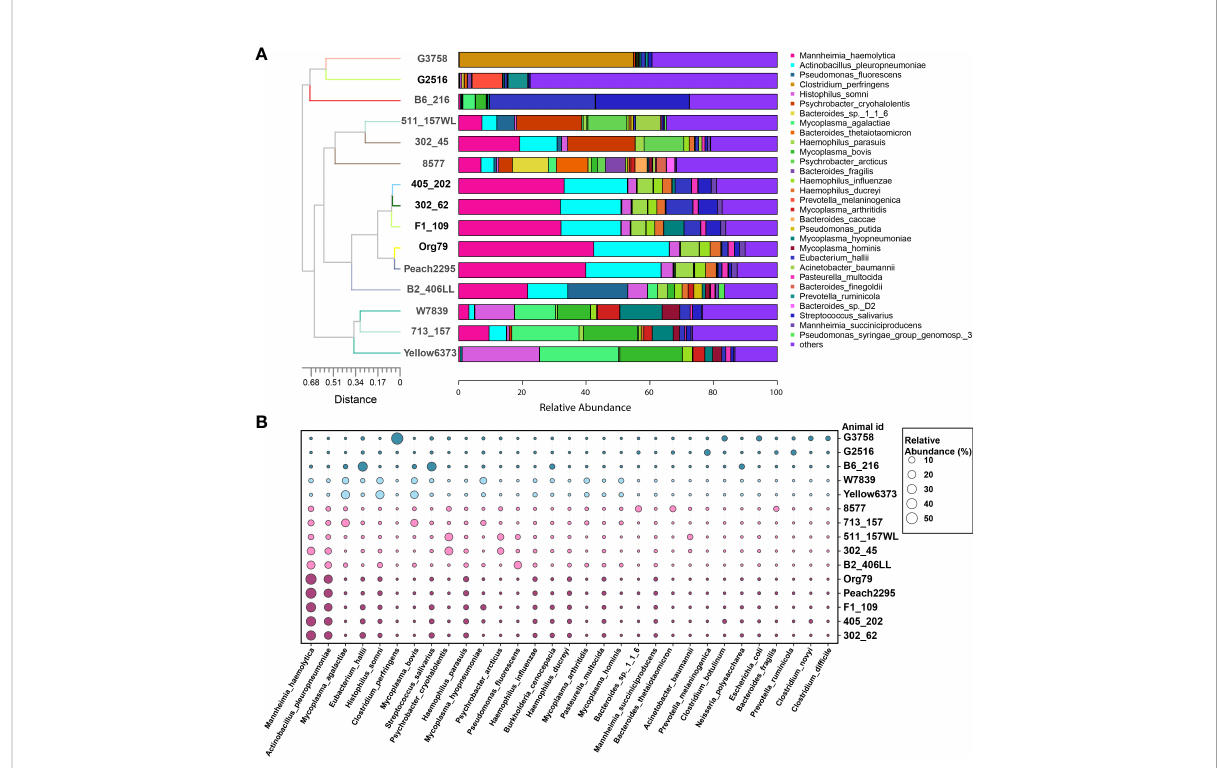
FIGURE 8 Individual variations and clusters of bovine lung microbiome. (A) Top 30 bacterial species in bronchoalveolar lavage were used for clustering analysis. (B) The major bacterial species distribution in the lungs. Circle size proportionally represents the relative abundance of bacterial species at a certain